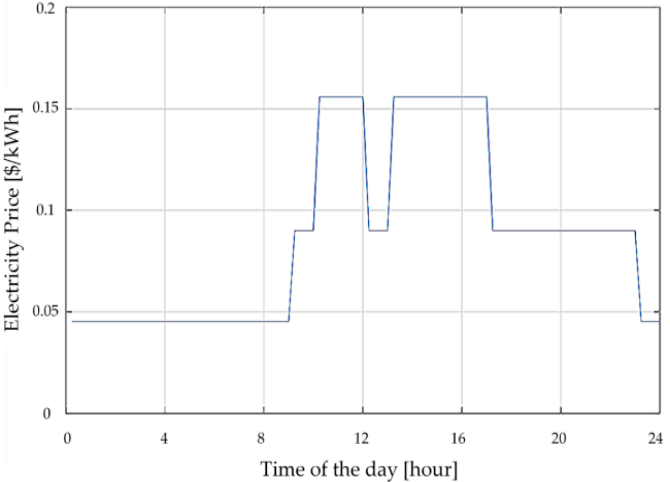
Figure 4. Electricity price applied to the simulation.